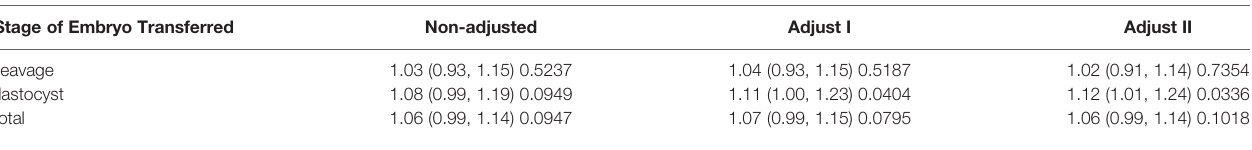
TABLE 4 | Relationship between EMT and OPR in women ≥ 35 years of age in two different models. Stage of Embryo Transferred